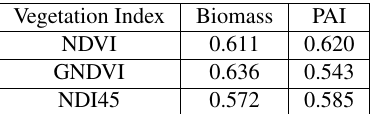
Figure 9. Statistical analysis of NDVI with PAI and biomass. Table 2. Correlation coefficient (r) of crop biophysical parameters and